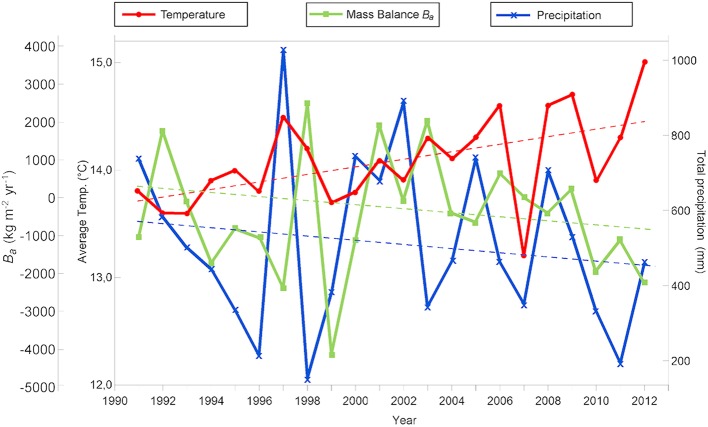
Mean temperature, total precipitation in the zone and mass balance of Echaurren Glacial per year between 1991 and 2012 (Source: Dirección Meteorológica de Chile, 1991–2012; World Glacier Monitoring Service (WGMS), 2015). Dotted lines showed linear regressions.